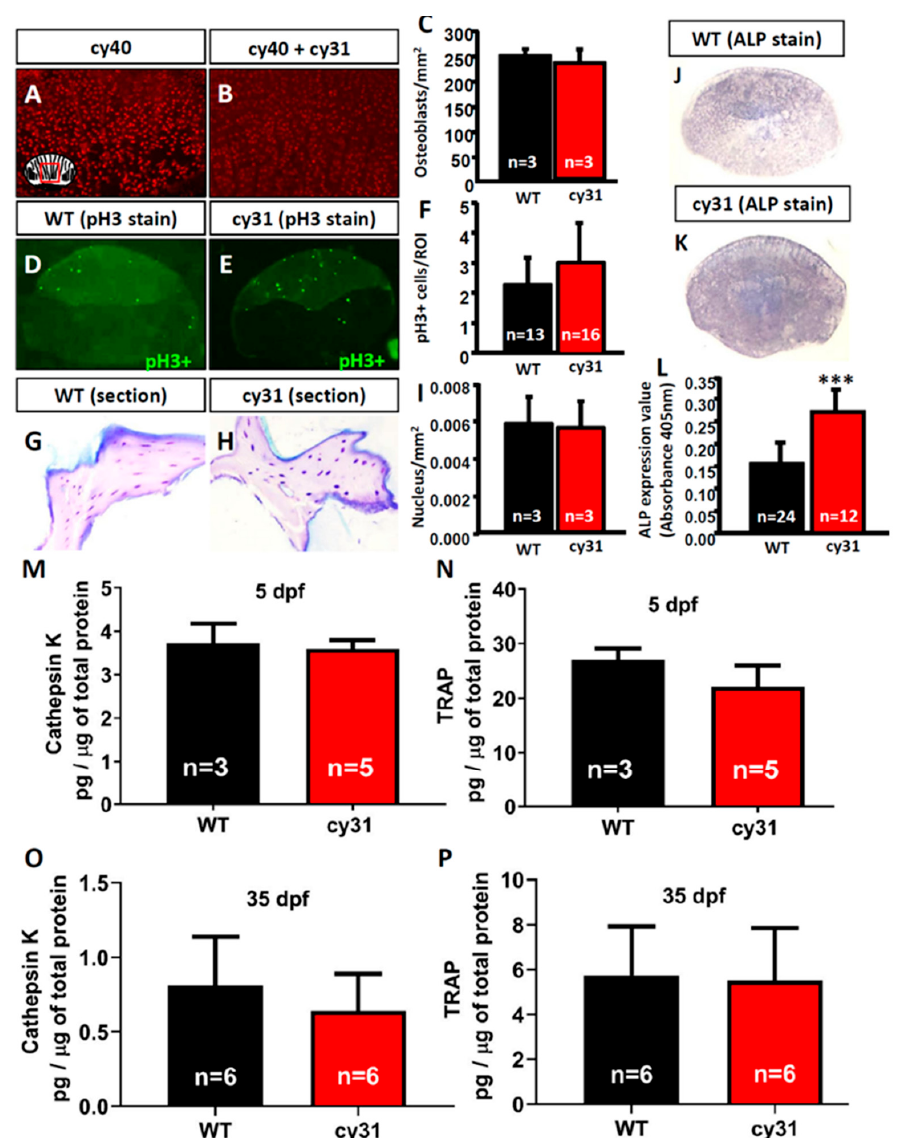
Figure 7. Detection of osteoblast and osteoclast activity in Tg(Ola.Sp7:N1aICD) cy31 fish. Quantification of the osteoblast number in wild type ( A ) and N1aICD-overexpressing Tg(Ola.Sp7:N1aICD) cy31 fish ( B ) scales with the aid of nucleus-tagged red fluorescent signals from Tg(Ola.Sp7:HA2FZmcherry) cy40 . The quantitative and statistic comparison data for osteoblast number were summarized in ( C ). Phospho-Histone H3 (pH3) immunostaining to measure the mitotic division activity for wild type ( D ) and N1aICD-overexpressing Tg(Ola.Sp7:N1aICD) cy31 fish ( E ) scales. The quantitative and statistic comparison data for pH3-positive cell number were summarized in ( F ). H&E staining and nucleus quantitation of spinal bone sections for wild type ( G ) and N1aICD-overexpressing Tg(Ola.Sp7:N1aICD) cy31 fish ( H ). All number was determined by taking the average of osteoblast number in three areas on each individual scale or bone section. The quantitative and statistic comparison data for nucleus number were summarized in ( I ). Alkaline phosphatase (ALP) staining of scales in wild type ( J ) and N1aICD-overexpressed Tg(Ola.Sp7:N1aICD) cy31 fish ( K ). Statistical analysis of ALP-positive staining area in fish scales ( L ). Relative ALP activity in fish scale lysates was quantitatively detected at 405 nm. Quantitative comparison of cathepsin K ( M , O ) and TRAP ( N , P ) protein expression levels in wild type and N1aICD-overexpressed Tg(Ola.Sp7:N1aICD) cy31 fish aged at either 5 days poste-fertilization (dpf) ( M , N ) or 35 dpf ( O , P ). Significance was tested by Student’s t -test and data were presented as averages ± SD (*** p < 0.005; n = fish number).